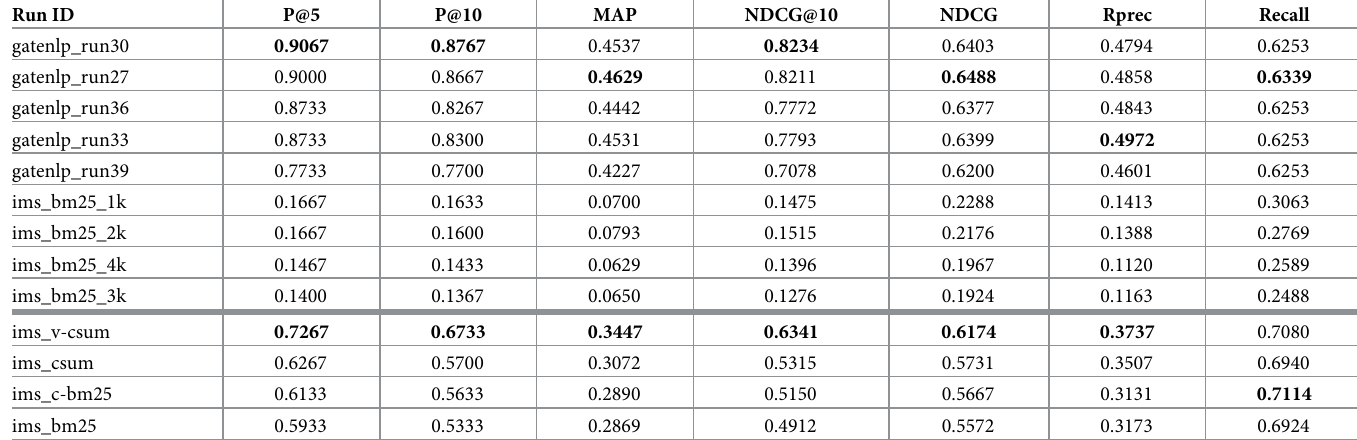
Table 6. Results for monolingual German runs. Our runs have gatenlp_ as a prefix in the name of the run. The first part of the table contains runs which retrieve 200 documents per query and the second part of the table contains runs which retrieve 1000 documents for each query. Best overall scores are highlighted in bold. Run ID